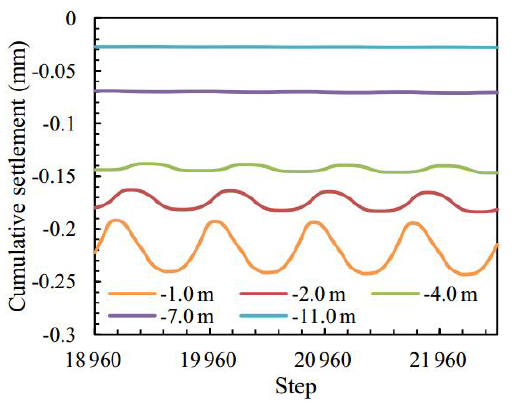
Figure 6. Variations of y -direction maximum stress with different locations.